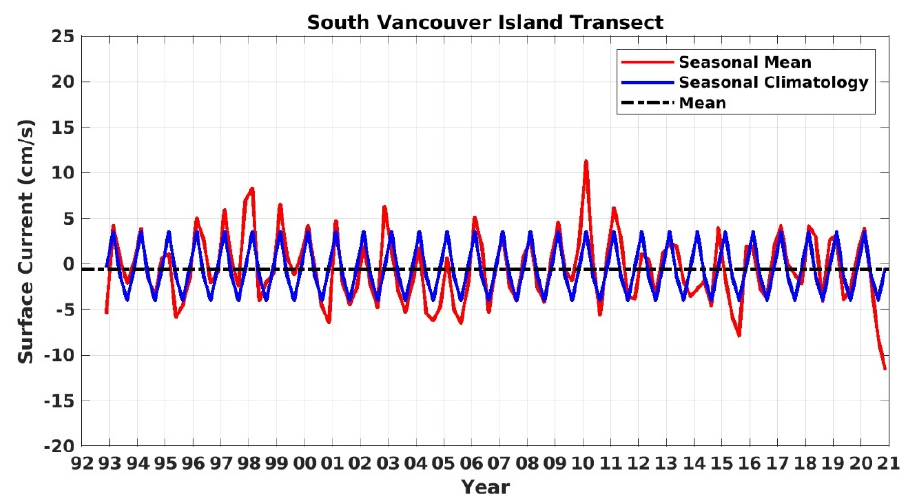
Figure 3. Seasonal-mean longshore geostrophic surface currents (positive poleward) over the conti- nental slope at the South Vancouver Island transect off the British Columbia coast. The currents are averaged over the transect (see Figure 1). Seasonal climatology is calculated by averaging seasonal means over the study period for winter, spring, summer, and fall, respectively. Mean is defined as the mean current averaged over the study period.